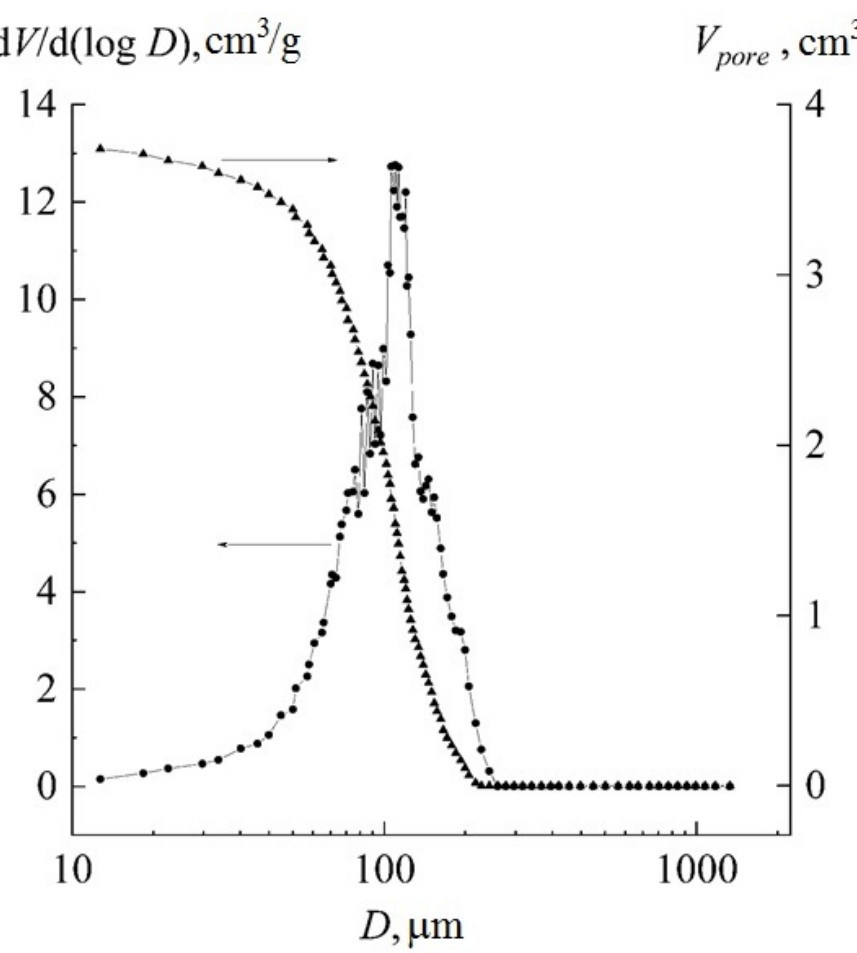
Figure 8. The pore size distribution of chitosan–polylactide